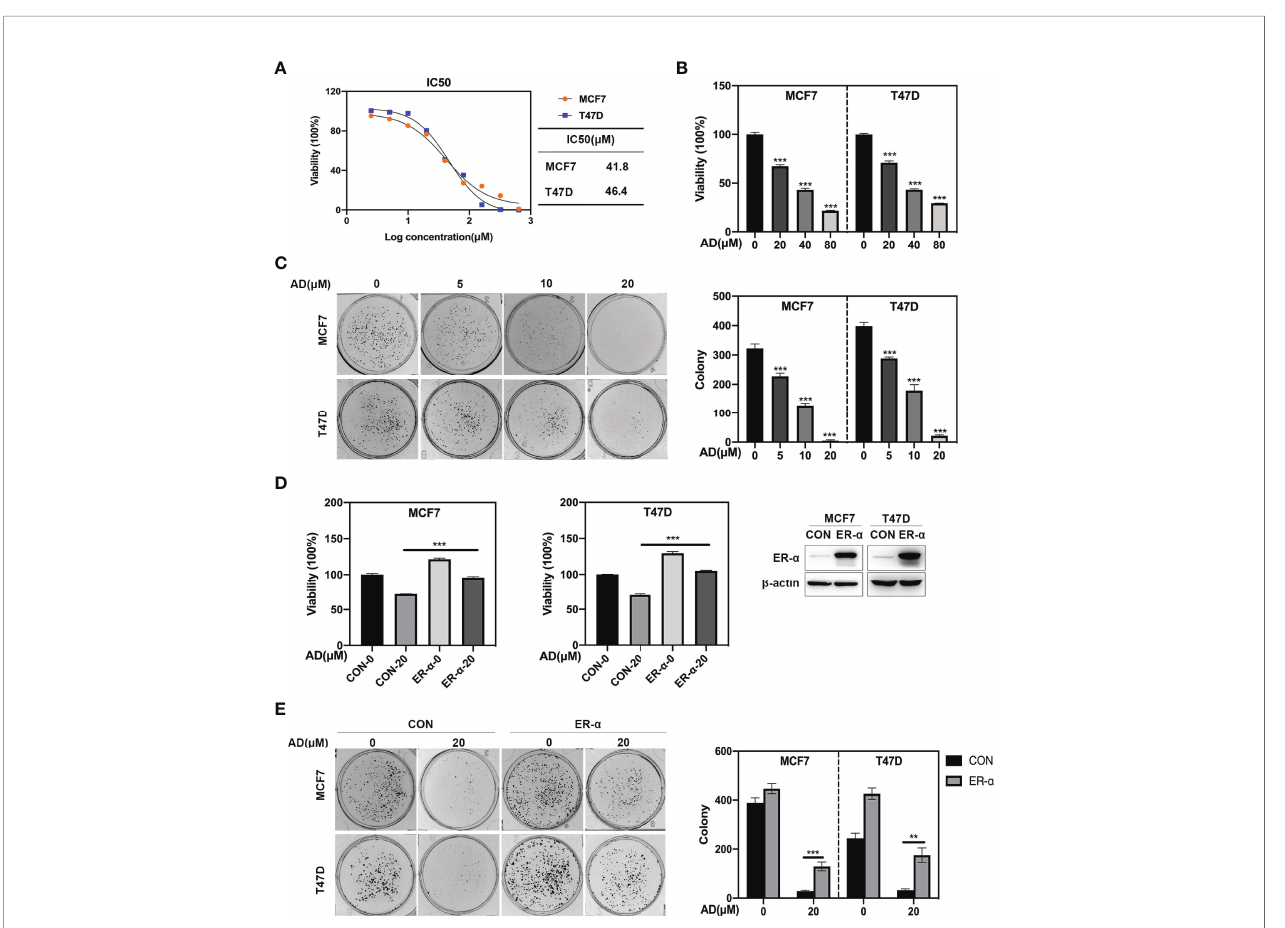
FIGURE 2 | AD inhibits breast cancer cell growth through down-regulating ER- a expression. (A) Cells were seeded in ATPlite plates in triplicate, 3000 cells per well, cultured overnight, and treated with 1 ‰ DMSO or various concentrations of AD (2.5, 5, 10, 20, 40, 80, 160, 320 and 640 m M) for 72 h. The ATPlite luminescence assay was used to determine the half-maximal inhibitory concentrations (IC50) of MCF7 and T47D cells, respectively. (B) Cells were seeded in ATPlite plates in triplicate, 3000 cells per well, cultured overnight, and treated with 1 ‰ DMSO or indicated concentrations of AD for 72 h, followed by the ATPlite luminescence assay. (C) Representative images of three independent experiments are shown for the inhibition of colony formation by AD. (D) The MCF7 and T47D cells were transduced with either control vector (MCF7/CON and T47D/CON) or human ER- a -expressing lentiviruses (MCF7/ER- a and T47D/ER- a ), followed by Western blotting to verify the ER- a expression. These control and ER- a -expressing cells were treated with AD (20 m M) for 72 h, followed by analyzing the cell proliferation rate using the ATPlite luminescence assay. (E) The MCF7/CON, MCF7/ER- a and T47D/CON, T47D/ER- a cells were treated with AD (20 m M) for 2 weeks, followed by analyzing the cell colony formation. (Data were presented as mean ± SD. ** P < 0.01 and *** P <